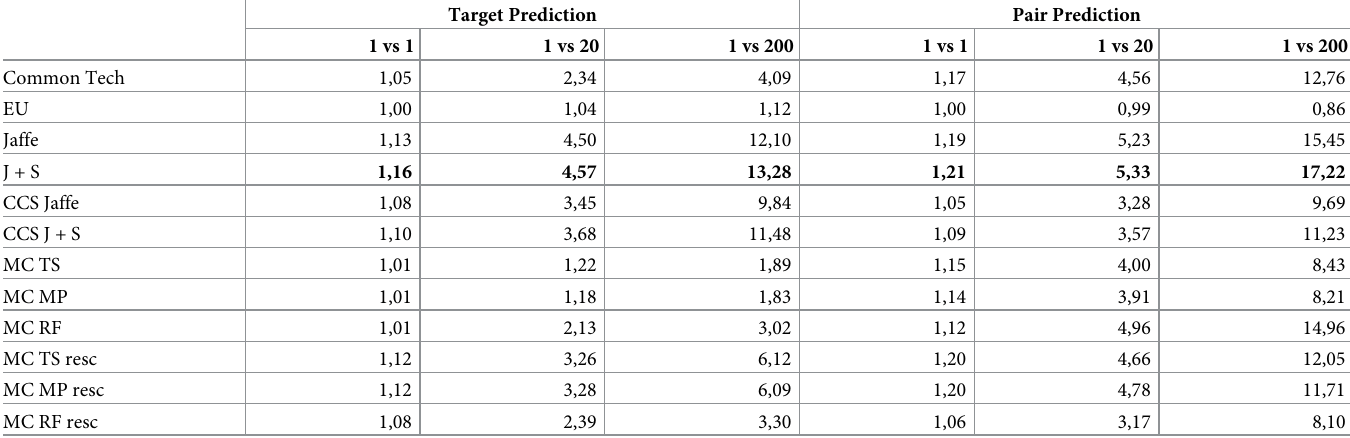
Table 1. Best-F1 values table of Fig 2. Jaffe + Sectors (J + S) constantly outperforms all the other measures on both Target and Pair Prediction and for all class imbalances. On the other hand, Euclidean Distance (EU) is always the worst performing. Due to the normalisation with respect to the random case, the Best-F1 values increase with the class imbalance, but the ranking of the different measures remains nearly the